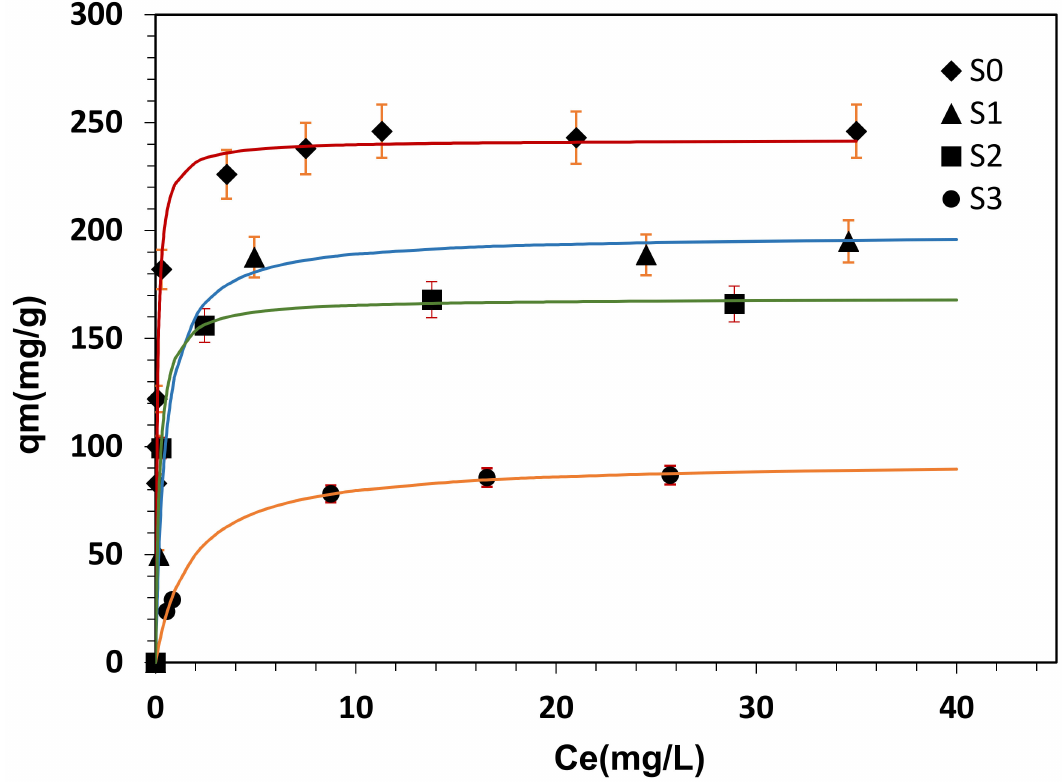
Figure 11. Adsorption isotherms of MB on raw material ( S 0 ) and activated clay samples ( S 1 , S 2 , S 3 ) with ± 5% error bars in uptake: The lines represent the fit of Langmuir model, (T = 20 ◦ C, pH = 7, m ads = 200